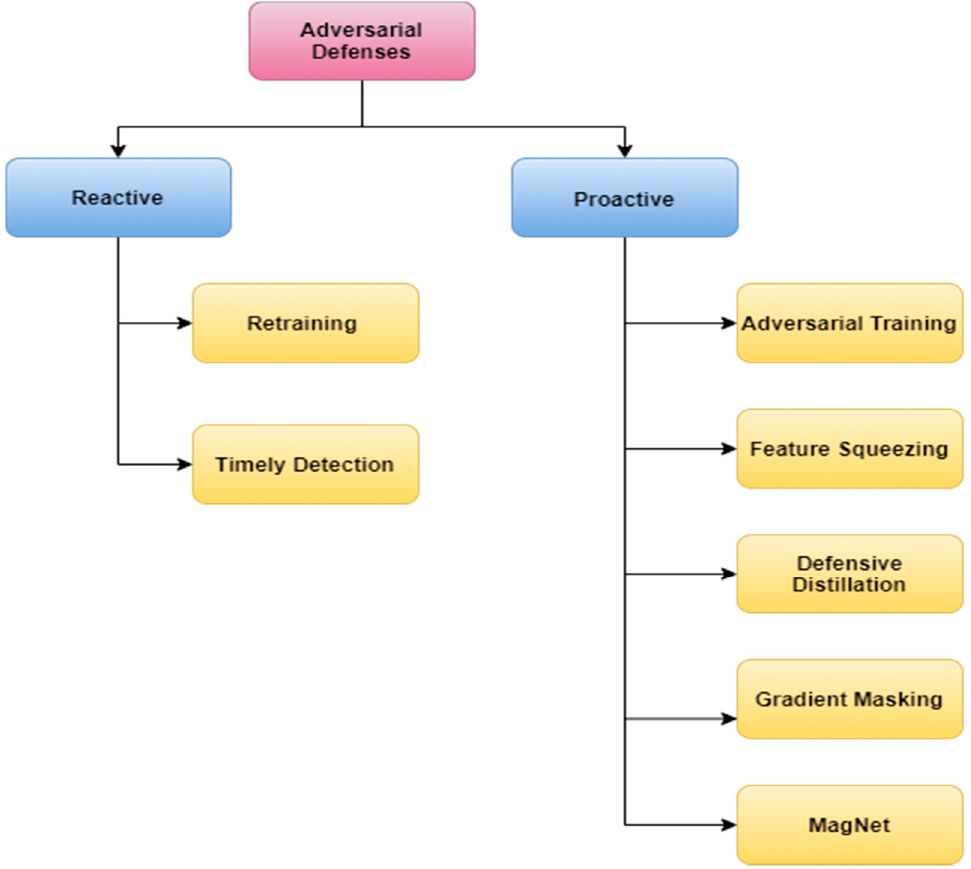
Figure 3. Different types of adversarial defenses and their classification.